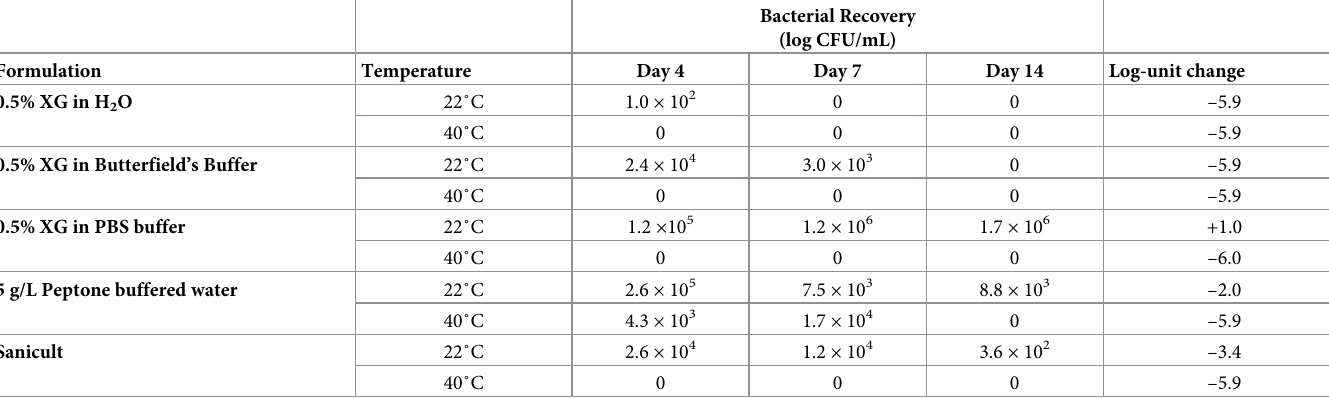
Table 3. Bacterial recovery of F . novicida in XG-based formulations.